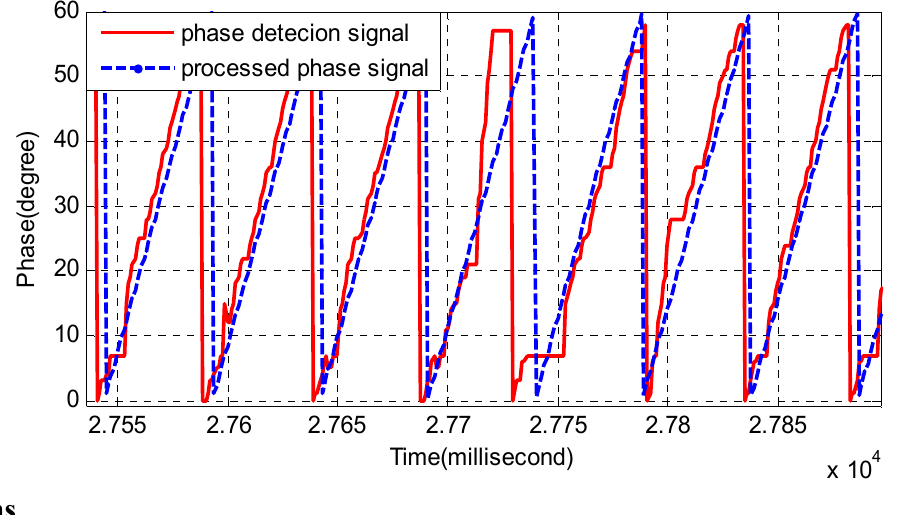
Figure 16. Comparison of the phase detection and processed phase